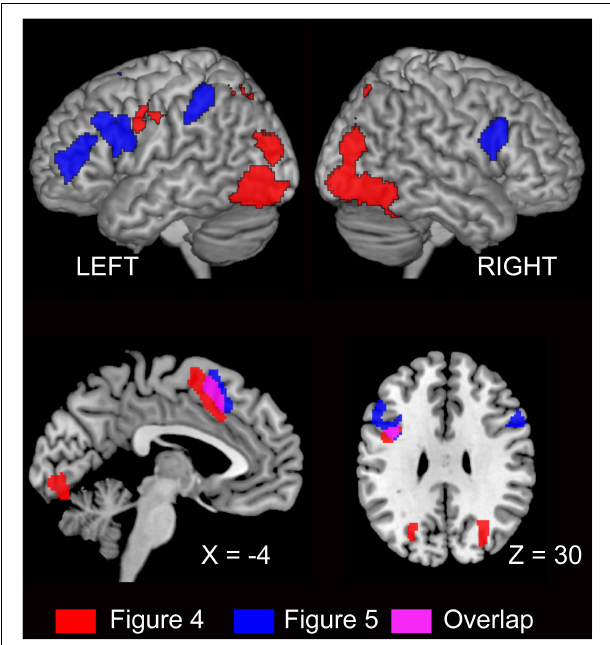
FIGURE 6 | Red represents semantic encoding-related areas ( Figure 4 ) and blue represents grammatical encoding-related areas ( Figure 5 ). Overlap in the pre-SMA is indicated by pink. The activation is superimposed on the high-resolution T1 weighted MR